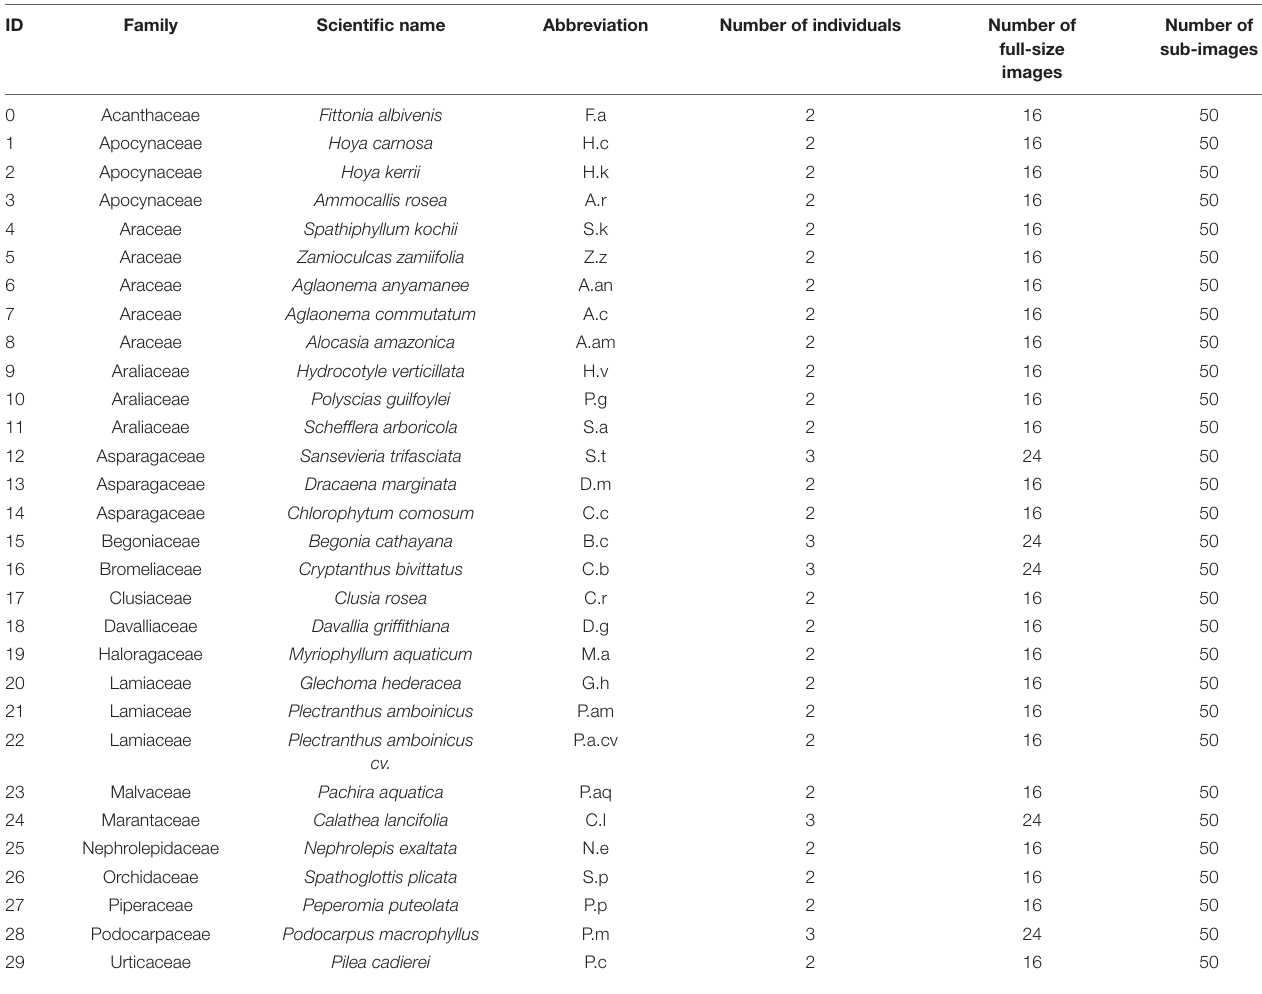
TABLE 1 | The taxonomy information and image samples list of the 30 plant